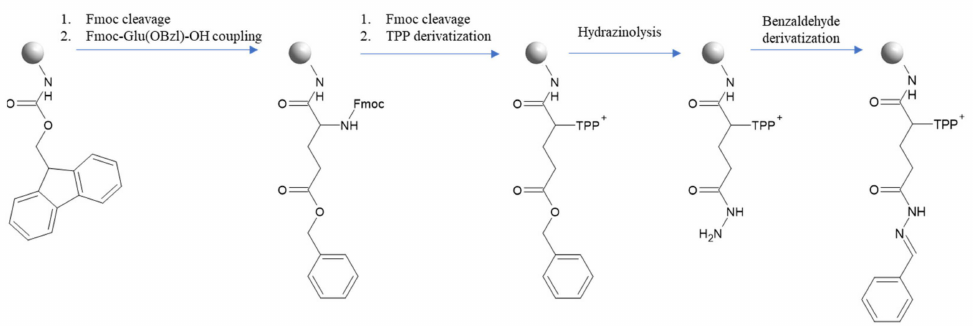
Figure 3. Immobilized glutamic acid-related hydrazine reagent, containing the QAS reaction